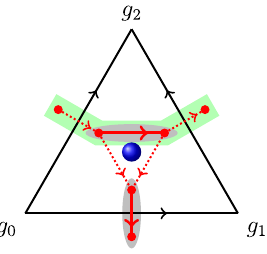
FIG. 2. Fermionic degrees of freedom in a triangle. The red dots represent Majorana fermions at the two sides of each link. The blue ball represents the complex fermion of the special group supercohomology model at the center of the triangle. The green strip is the decorated Kitaev ’ s Majorana chain onto the dual lattice P